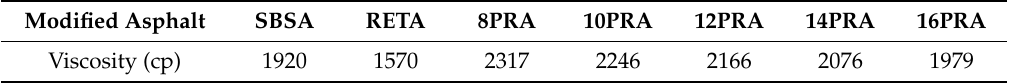
Table 10. The viscosity test results of modified